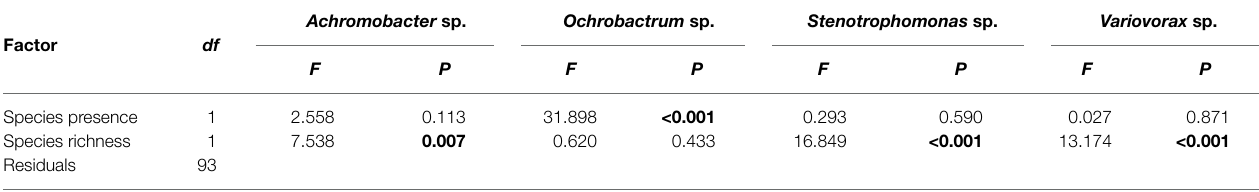
The bold values indicate significant effects. TABLE 2 | Analysis of variance table of F -values on the effects of presence of specific species, and species richness on the proportion of wrinkly spreader. Achromobacter sp. Ochrobactrum sp. Stenotrophomonas sp. Variovorax sp. Factor df F P F P F P F P Species presence 1 3.868 0.052